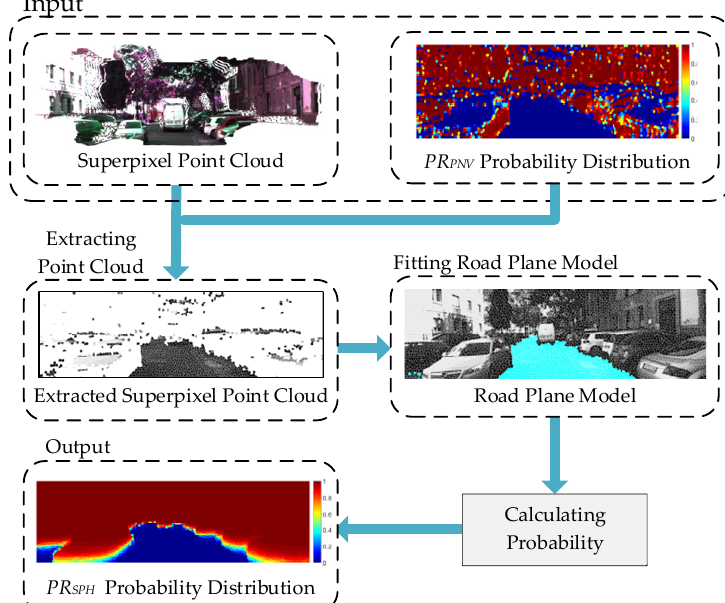
Figure 6. Flow chart of OD-SPH method.